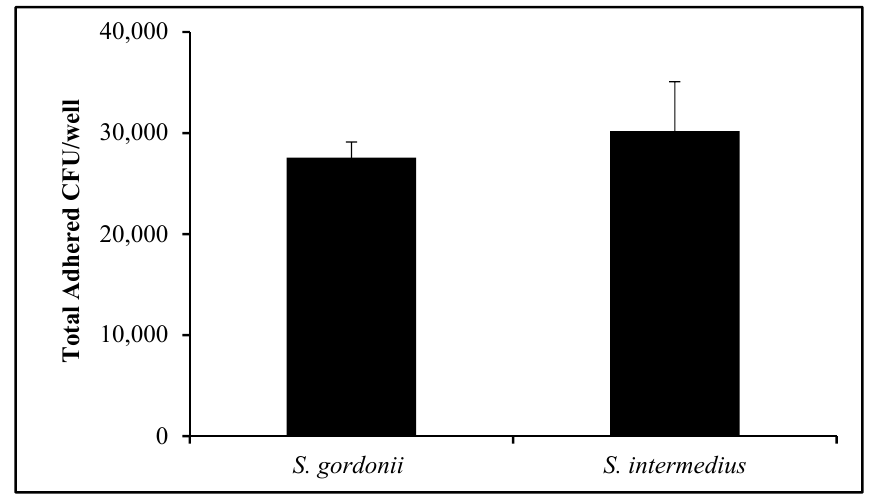
Figure 4. Adherence of commensal bacteria. Quantification of oral commensal streptococci CFUs after adherence to OKF6/Tert cells (MOI = 100) in 24-well plates. Graph represents the average and SD of six independent experiments.